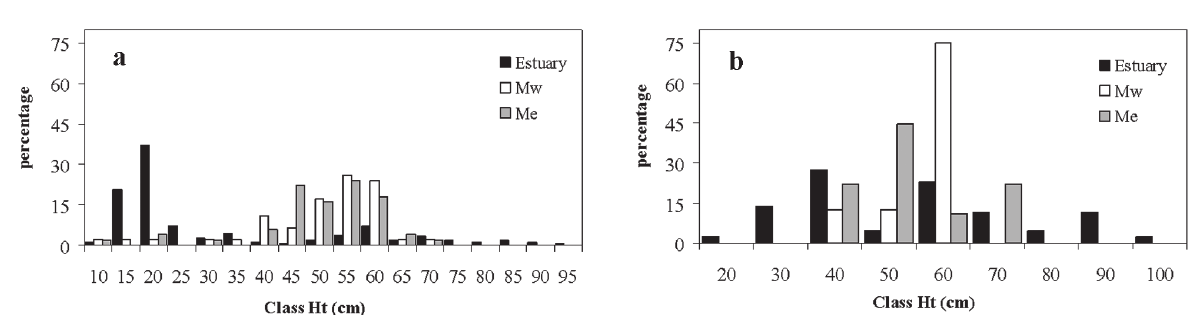
Fig . 3. − size distribution of live (a) and dead (b) specimens of P. nobilis for each sampling station